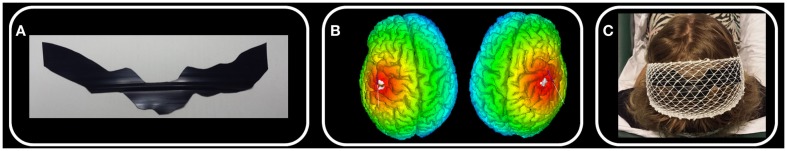
Whole body S1 personalized electrode. In one exemplificative subject, we schematize the main steps of electrode personalization [Ref. (14), see Materials and Methods). (A) After drawing the left and right central sulci using SoftTaxic software from individual 3D MRI, we fit this line by 2 cm wide parallelograms and we cut the electrode from a conductive silicon band. (B) We position the personalized stimulating electrode by proper neuronavigation procedure along the central sulcus with the center of the electrode crossing the nasion-inion line. (C) S1wb personalized electrode and the cathode electrode positioned on Oz.